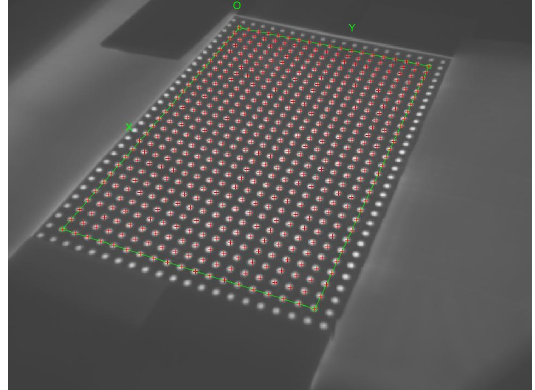
Figure 4. Determined grid